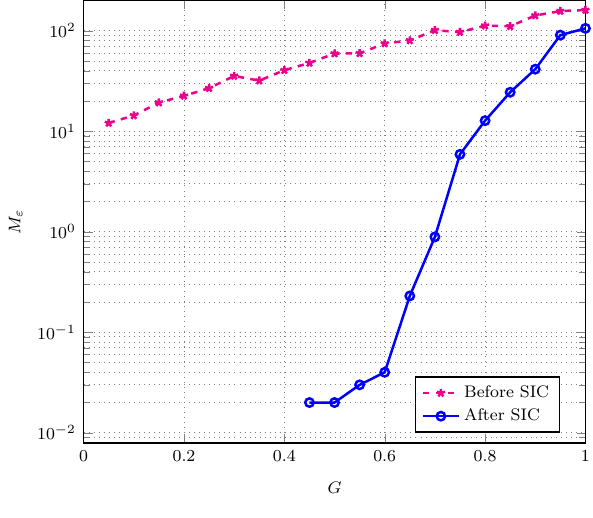
Figure 5. Mean squared error (MSE) versus G for IRSA with Λ ( x ) = 0.5 x 2 + 0.28 x 3 + 0.22 x 8